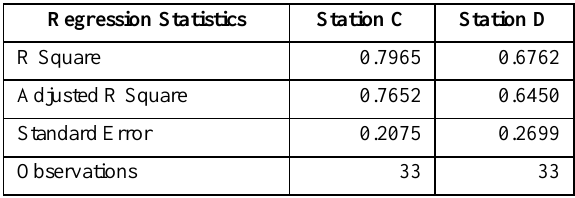
Table 2. Summary of regression statistics for seagrass percent cover from drone and field observations